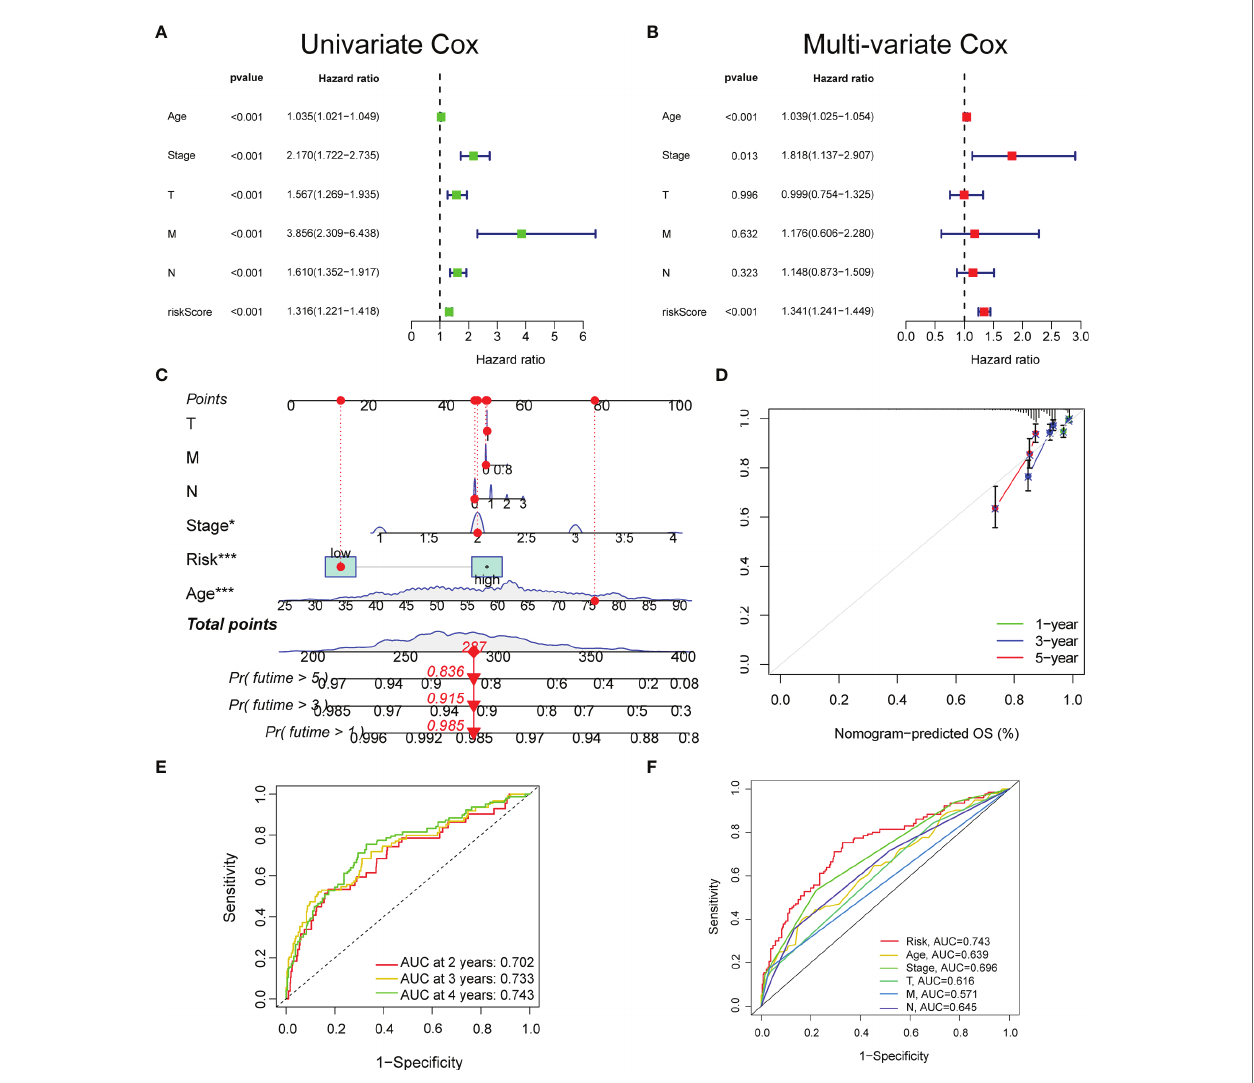
FIGURE 3 | The prognostic value of the glyco-signature. The univariate (A) and multivariate (B) Cox regression analyses of the prognostic capability of risk score and other clinicopathological features. (C) Construction of a nomogram based on the risk score and other clinicopathological factors to predict 1-, 3-, and 5-year OS of BC. (D) Calibration curves of the nomograms to validate the consistency between nomogram results and actual 1-, 3-, and 5-year survival outcomes of BC. (E) ROC curve analysis and AUC at 2, 3, and 4 years for the risk score. (F) ROC curve analysis and AUC at 4 years of the risk score and other clinicopathological factors. OS, overall survival; BC, breast cancer; ROC, receiver operating characteristic; AUC, area under the curve. *p < 0.05, ***p <